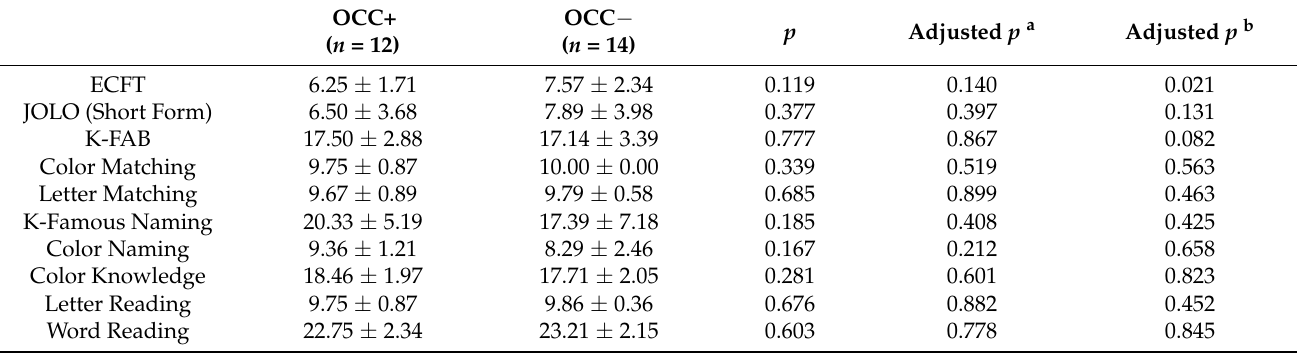
Table 4. Visuoperceptual function test